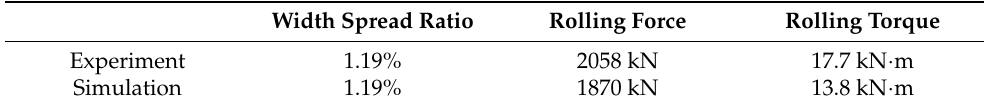
Table 2. Comparison of experimental and simulation results for the S45C plate.